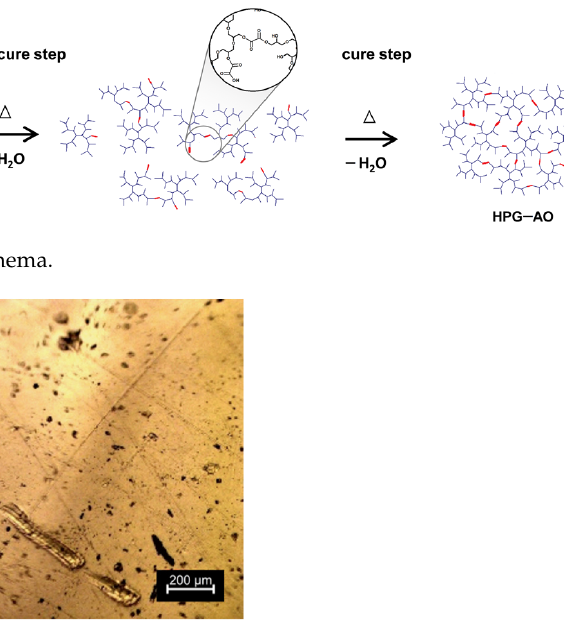
Figure 2. Oxalic acid crosslinked hyperbranched polyglycerol hydrogel HPG-OA1: ( a ) photography and ( b ) optical microscopy image obtained in transmission mode (100×).